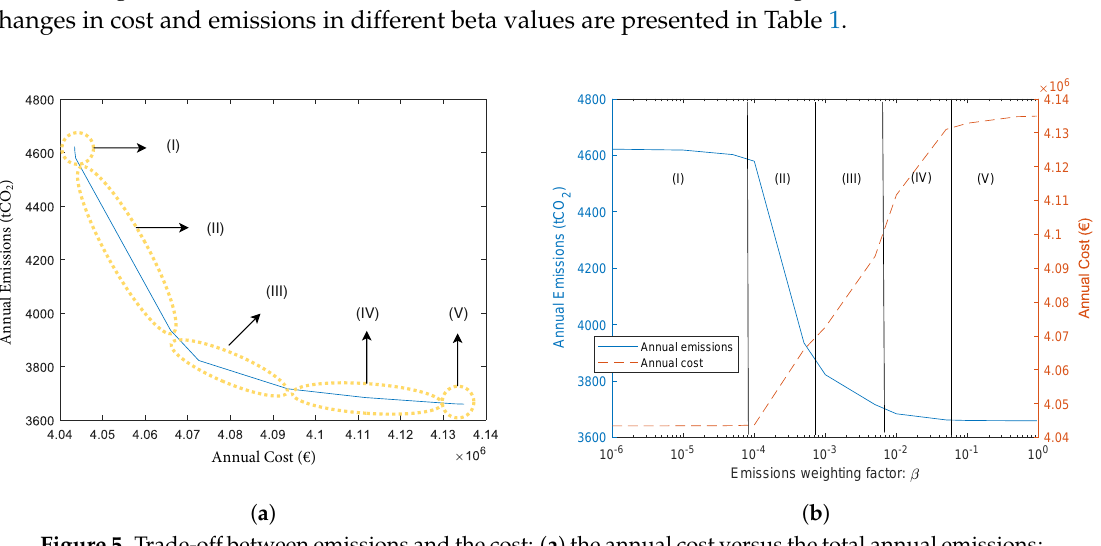
Figure 5. Trade-off between emissions and the cost: ( a ) the annual cost versus the total annual emissions; and ( b ) the annual cost and the annual emissions at different β . The roman numerals are the different abatement phases explained in Section